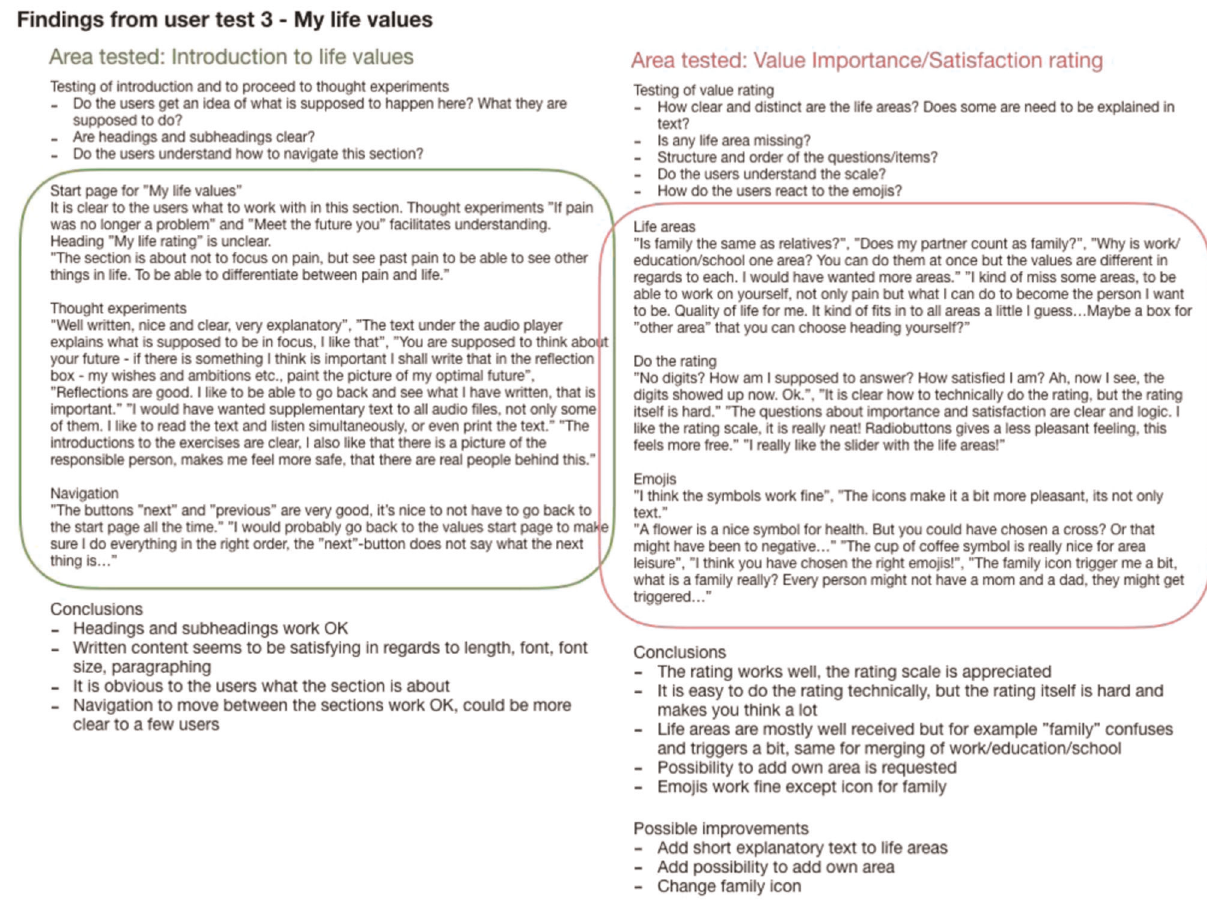
Fig. 3 Example of documentation of results after alpha testing a feature of the solution (translated from Swedish to English).